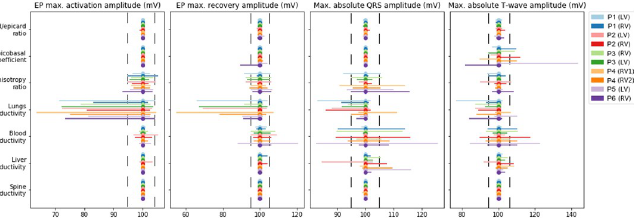
Fig 7. Variation in the amplitude characteristics of depolarization and repolarization (see annotation on top of the panels) due to univariable parameter variations (see annotation in the left column) in the models. The figure design is the same as in Fig